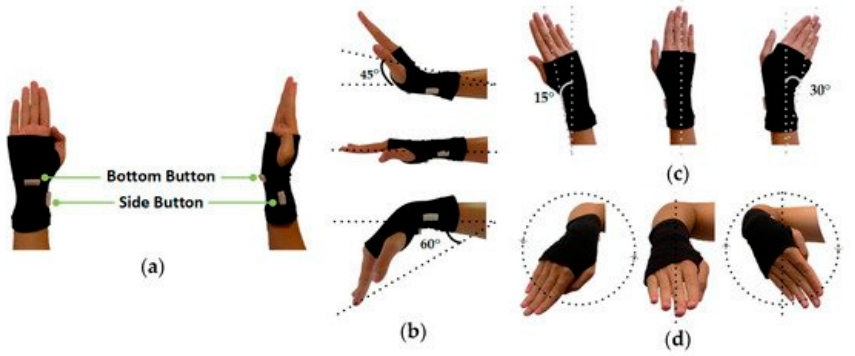
Figure 5. Glove-embedded strain sensor captures gestures for vehicle control: prototype ( a ) and movement in vertical ( b ), horizontal ( c ), left–right ( d ) directions [16]. Licensed under a Creative Commons Attribution (CC BY) license.